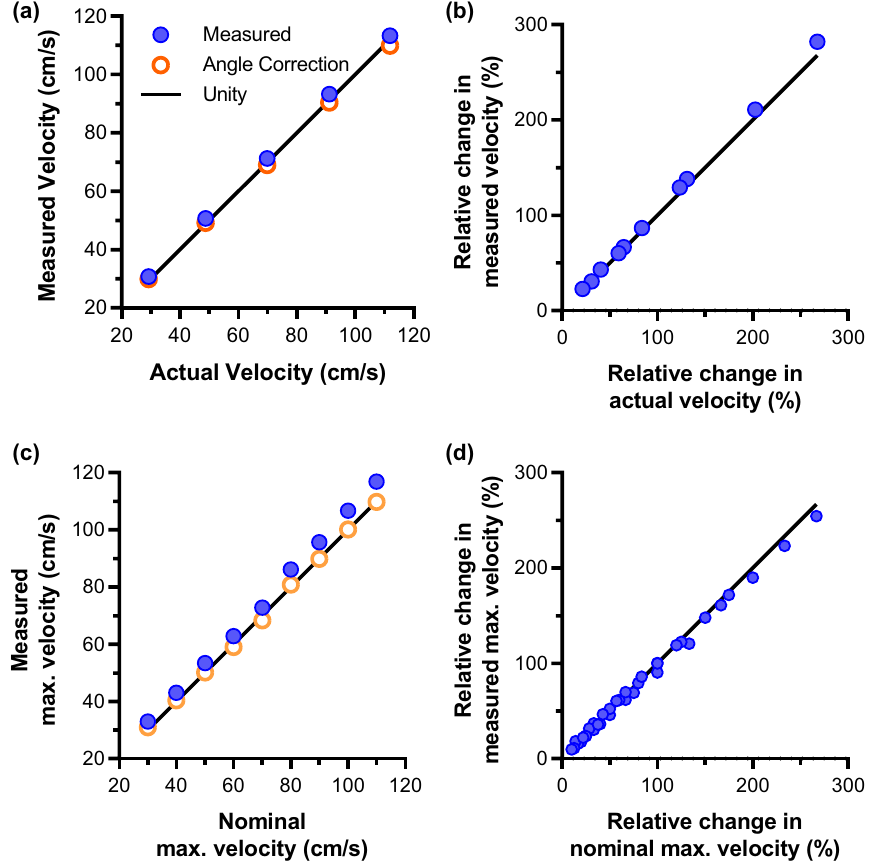
Figure 4. In vitro validation results of CW patch velocity measurement, showing good tracking of absolute and relative velocities. ( a ) Absolute velocity measured by CW patch on a string phantom. A 1° angle correction improves the agreement between measured and actual velocities. ( b ) Comparison between measured relative change in velocity and actual relative change on a string phantom. ( c ) Comparison of absolute measured maximum velocity and nominal maximum velocity on a flow phantom. A 2° angle correction improves the agreement. ( d ) Good agreement between measured and nominal maximum velocity in a flow